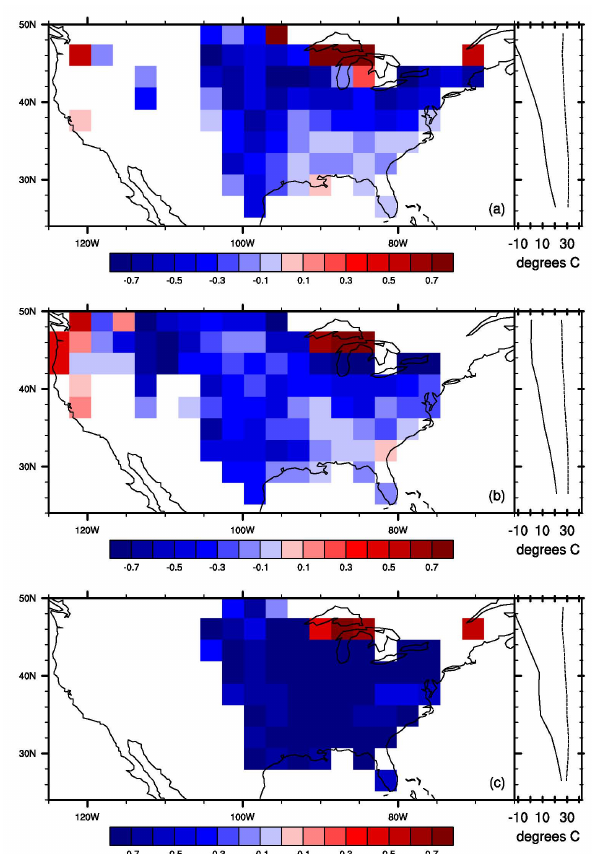
Fig. 9. Correlation coefficient between temperature and yield for (a) maize, (b) spring wheat, and (c) soybean. The right half of each panel shows the latitudinal maximum and minimum temperatures ( ◦ C) during the growth period for each